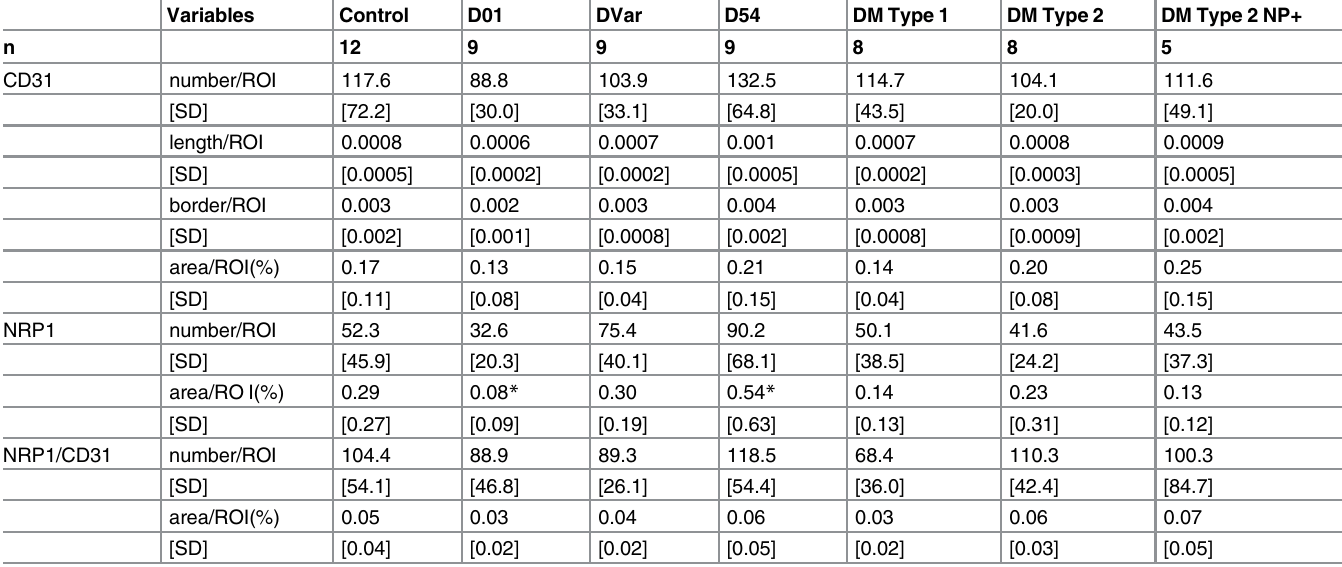
CD = Cluster of differentiation; DM = diabetes mellitus; DX = day X after capsaicin is applied; NP+ = presenting polyneuropathy; NRP-1 = Neuropilin-1 receptor; ROI = region of interest; SD = Standard Deviation; Var = variable * indicates signi fi cance.